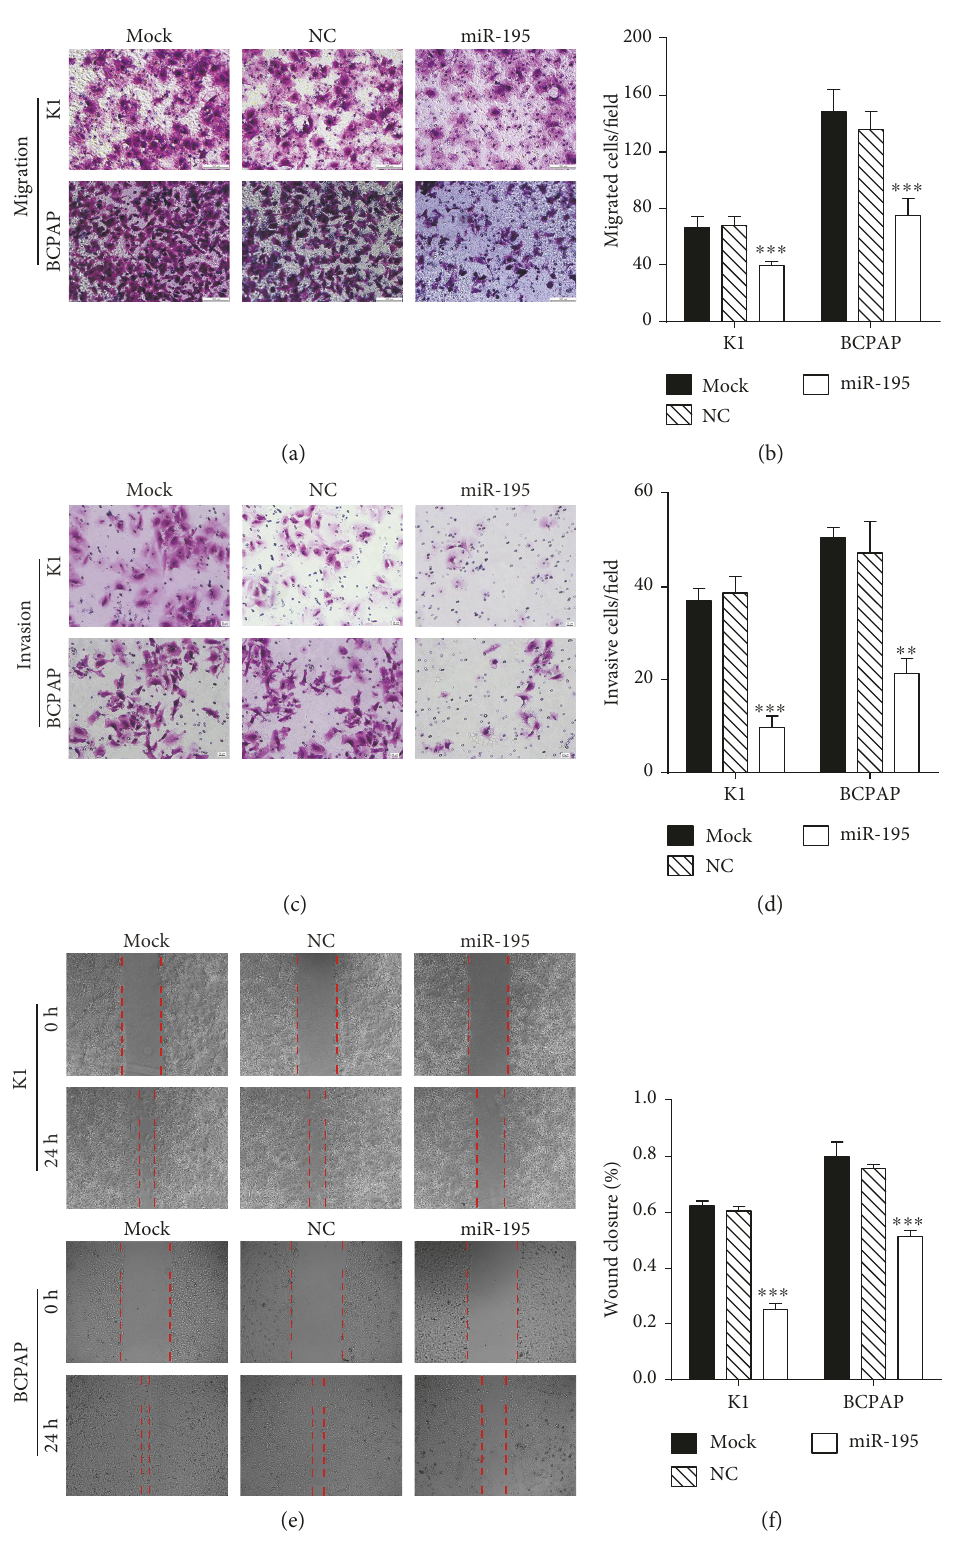
Figure 4: MiR-195 suppresses PTC cell migration and invasion. (a) Transwell migration assays of K1 and BCPAP cells overexpressing miR-195 were performed without the Matrigel-coated chamber. Magni fi cation, 200x. (b) Quanti fi cation of migrated cells. (c) Transwell invasion assays of K1 and BCPAP cells overexpressing miR-195 were performed with the Matrigel-coated chamber. Magni fi cation, 200x. (d) Diagrams of invasive cells. (e) Wound healing assays of PTC cells after transfection of miR-195 . (f) Percentage of wound healing closure assays. ∗∗ P < 0 01 compared with the control group, ∗∗∗ P < 0 001 compared with the control